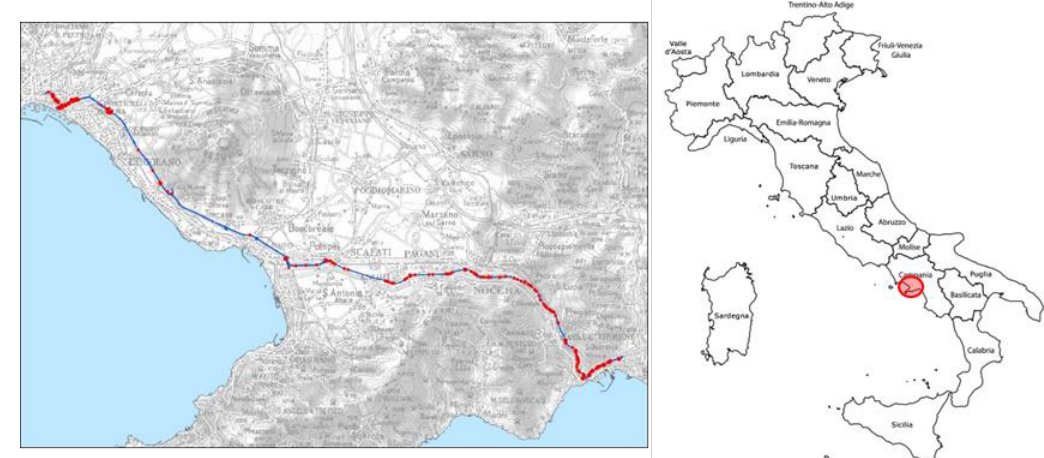
Figure 2. Bridges and viaducts (red circle) on the A3 highway (blue line).